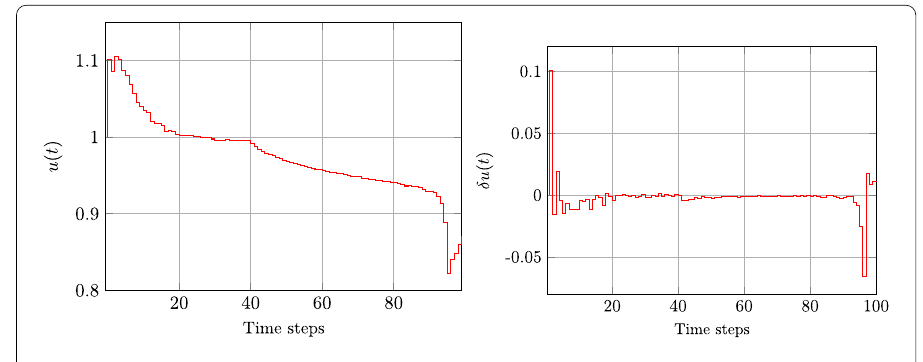
Fig. 21 Evolution of the command variable (left) and its incremental corrections (right) along the controlled welding process - Case 2